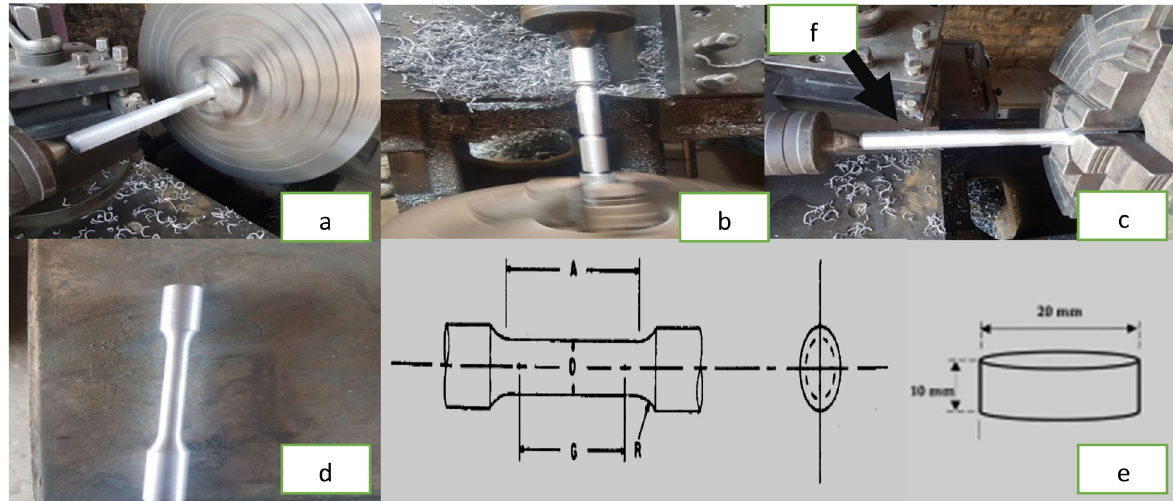
Figure 7: Machining operations and ASTM standards ( E8M and E18 - 05 ) : ( a ) an isometric view; ( b ) top view; ( c ) side view; ( d ) sample; ( e ) sketch of the standard; and ( f ) cutting tools.